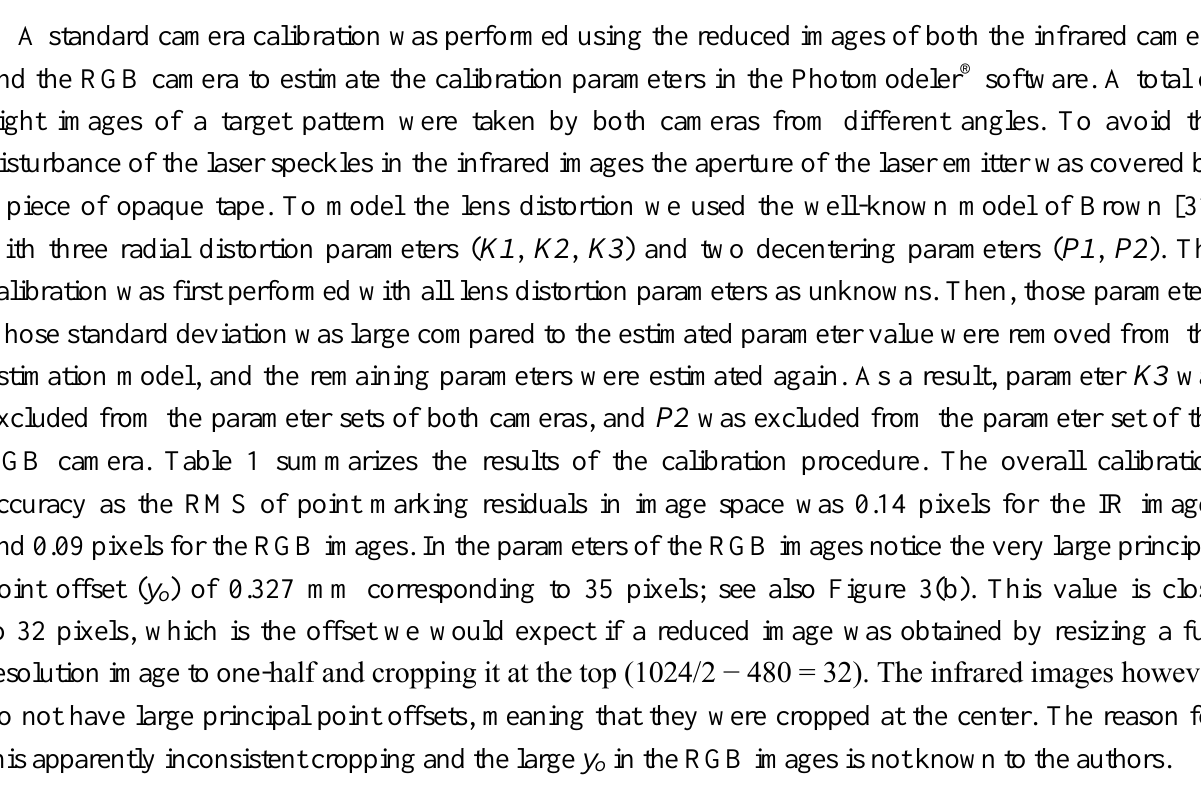
Table 1. Calibration parameters estimated for the infrared and RGB